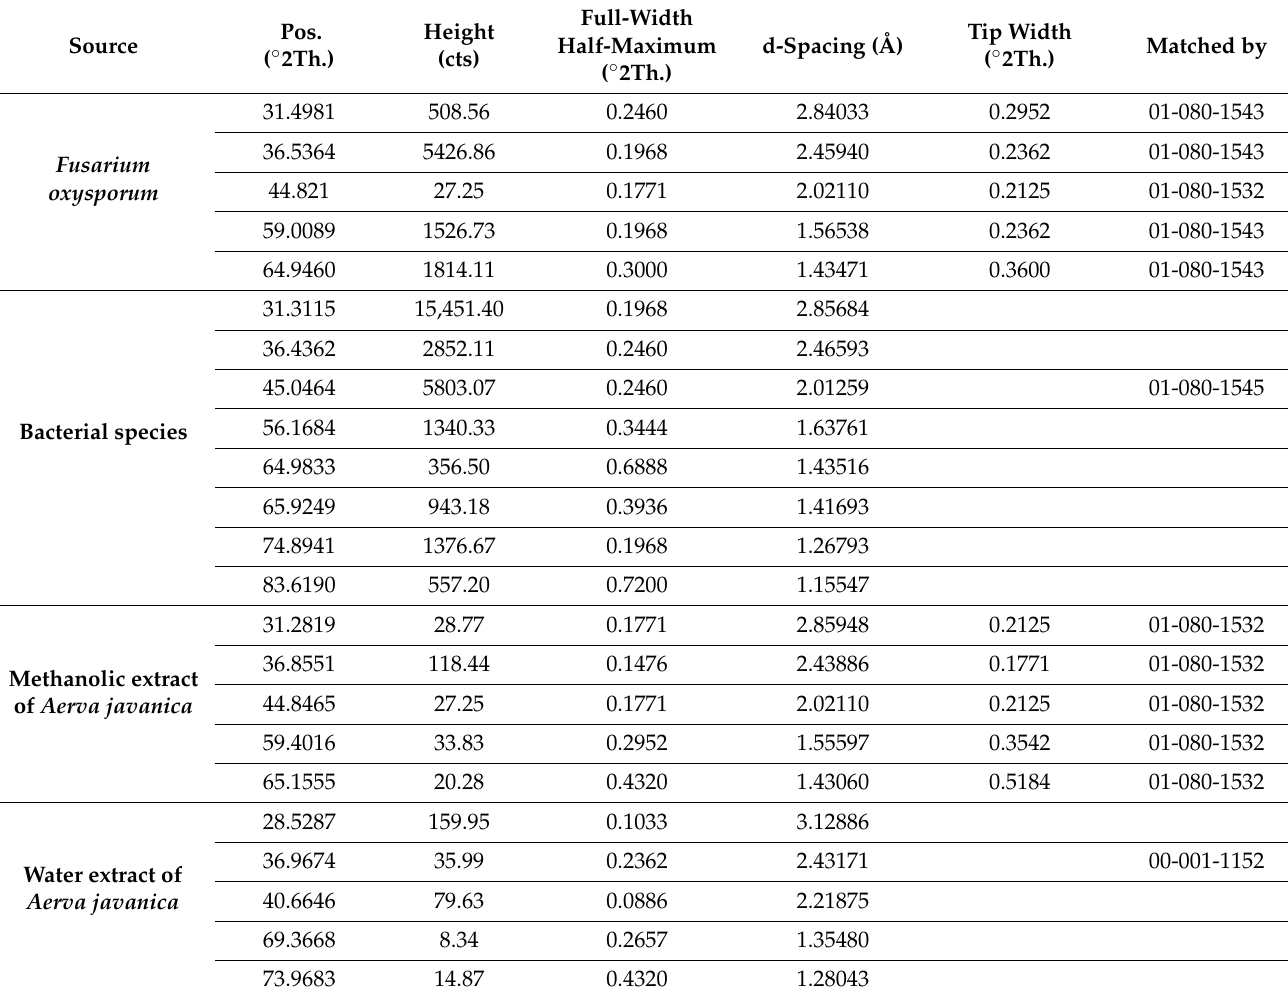
Table 3. Peak detail of XRD pattern of cobalt oxide synthesized from Fusarium oxysporum , bacterial species, methanolic extract of dried aerial part of Aerva javanica and water extract of dried aerial part of Aerva javanica .